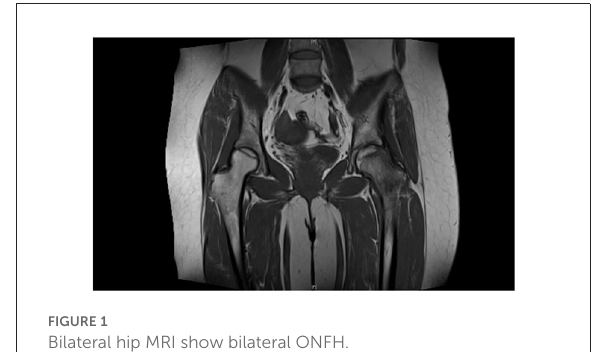
FIGURE1 Bilateral hip MRI show bilateral